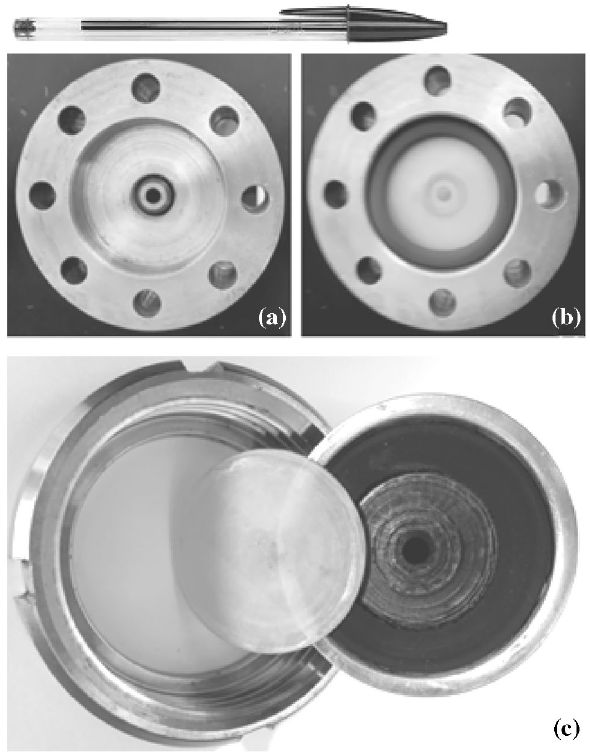
Fig. 1 Sealing system of the previous equipment with permeation chamber open without a sample ( a ), sample with O-ring ( b ) and permeation chamber of the current permeameter open with a sam- ple and its sealing system ( c